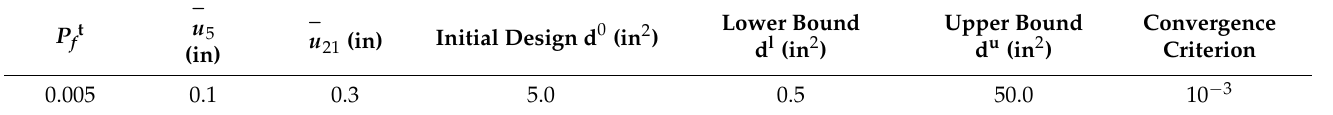
Figure 9. Truss cantilever structure: ( a ) dimension, loading, and boundary conditions; ( b ) deformed shape and displace- ments of interest; ( c ) truss element numbers, and ( d ) node numbers. Table 11. Parameters for the target failure probability and